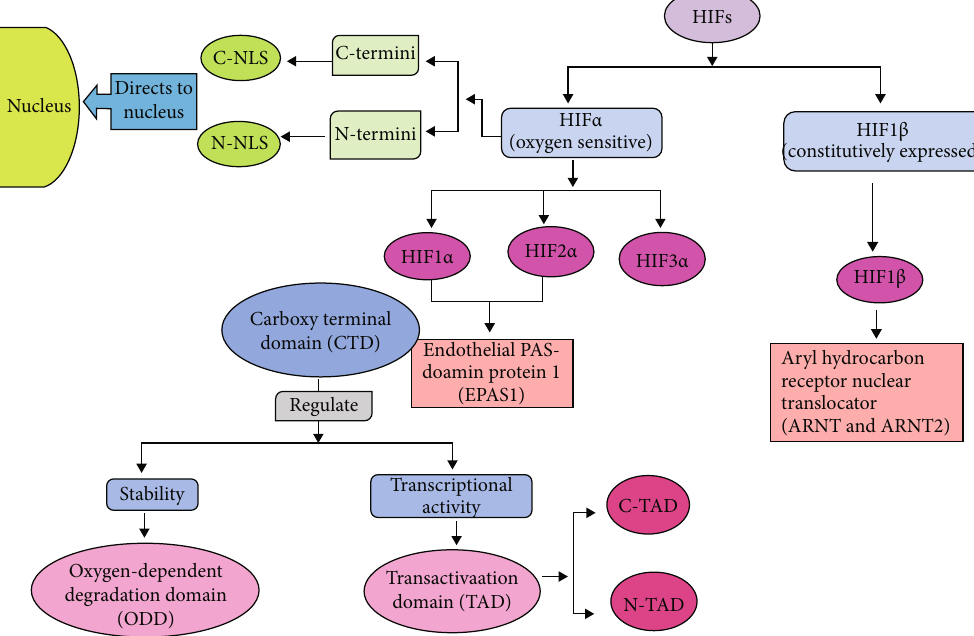
Figure 3: Structural and functional organization of hypoxic inducible factors (HIFs). HIF is a heterodimeric complex composed of an oxygen-dependent α -subunit (HIF- α ) and an oxygen-insensitive β -subunit (HIF- β ). The HIF- α has three subunits (HIF-1 α , HIF-2 α , and HIF-3 α ). The regulation of HIF-1 α and HIF-2 α is done by oxygen tension and is ubiquitously expressed in the normal tissue, whereas the HIF-1 β is the subunit of HIF- β . The carboxy-terminal domain (CTD) of HIF-1 α and HIF-2 α based on their regulation is divided (indicated by black arrows) into two domains: ODD (regulates stability) and TAD (regulates transcriptional activity via two transactivation domains (TADs)) — (i) N-TAD and (ii) C-TAD. Some nuclear localization signals (NLS) are present in both the C and N- termini of the α -subunits such as N-NLS and C-NLS that give it the direction towards the nucleus.